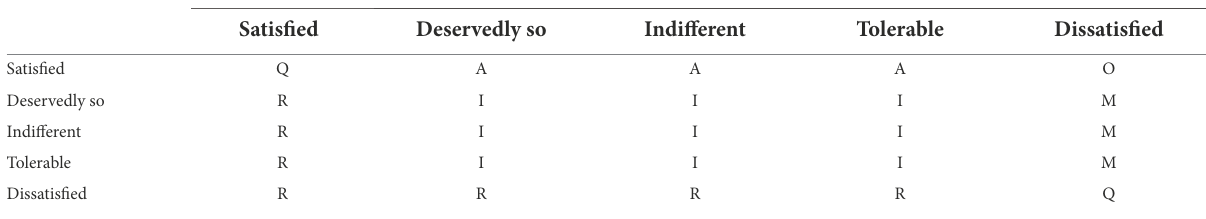
TABLE 2 Kano model attribute classification